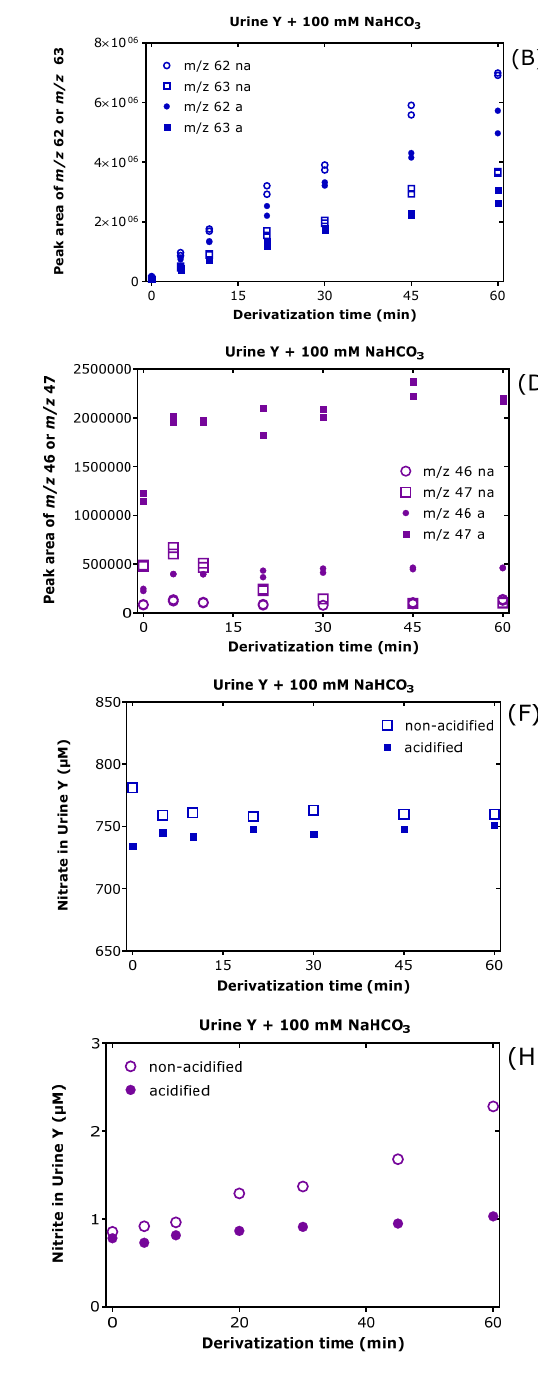
Figure 4. Effects of exogenous bicarbonate and of the ingestion of acetazolamide on nitrate and nitrite analysis by GC-MS after derivatization with PFB-Br for the indicated times at 50 °C in two different human urine samples. The samples were derivatized before and after acidification with 20 wt.% acetic acid. The concentrations of the internal standards in the urine samples were 400 µM [ 15 N]nitrate and 4 µM [ 15 N]nitrite. Urine X ( A , C , E , G ) was collected upon ingestion of a 500-milligram tablet acetazolamide from a previous study [6]. Urine Y ( B , D , F , H ) was freshly collected by a healthy volunteer (author of the present article) and spiked with 100 mM NaHCO 3 . Data are shown from two independent experiments. All nitrite and nitrate species were measured simultaneously by GC-MS using selected-ion monitoring of m/z 46 for [ 14 N]nitrite, m/z 47 for [ 15 N]nitrite, ( B ) m/z 62 for [ 14 N]nitrate and m/z 63 for [ 15 N]nitrate. Left panels, Urine X; right panels, Urine Y. Acidified, close symbols; non-acidified, open symbols.